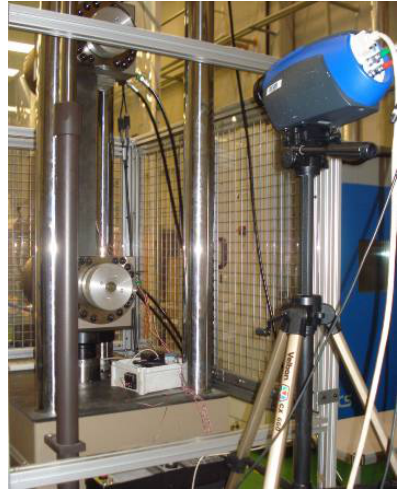
Figure 6. Layout of thermography